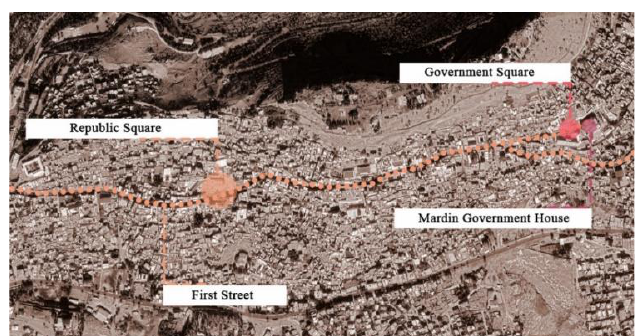
Fig. 9. The historical city of Mardin and the Old